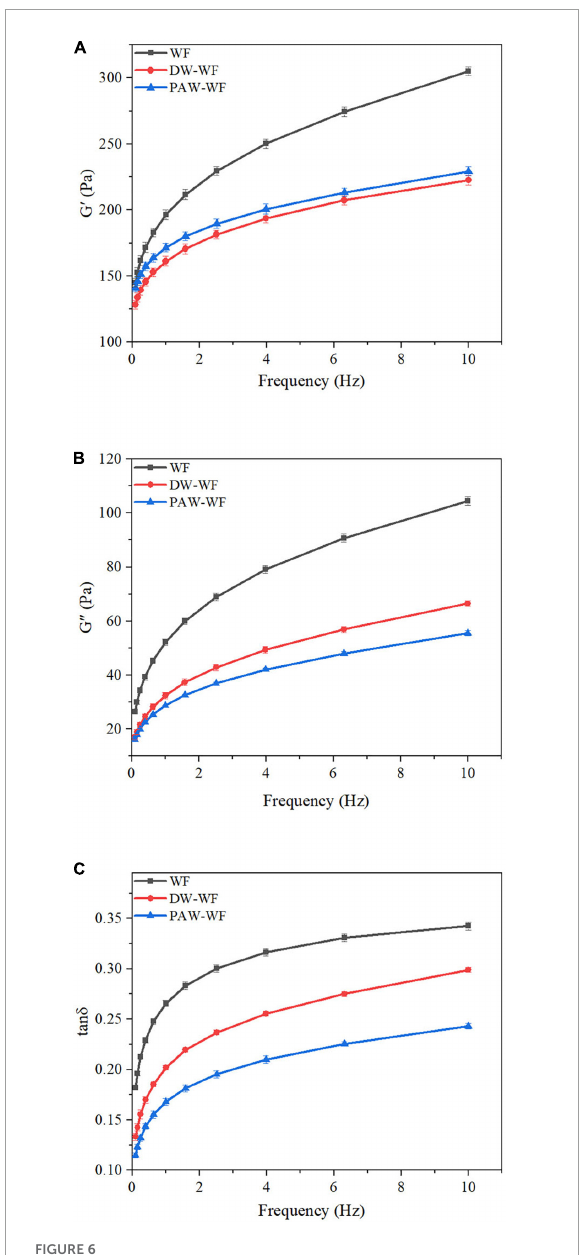
FIGURE6 Dynamic rheological curves of WF and modified WF. (A) Storage modulus (G’) of WF, DW-WF and PAW-WF; (B) Loss modulus (G”) of WF, DW-WF and PAW-WF; and (C) Loss tangent (tan δ ) of WF, DW-WF, and